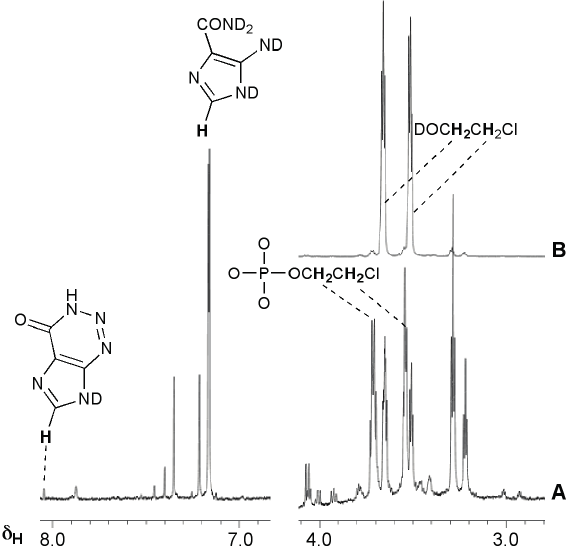
Figure 2. Reaction of MTZ with phosphate buffer pD = 7.8, 37 °C. ( A ) 1 H-NMR spectrum after 14 days; ( B ) The same sample spiked with authentic chloroethanol ( 7